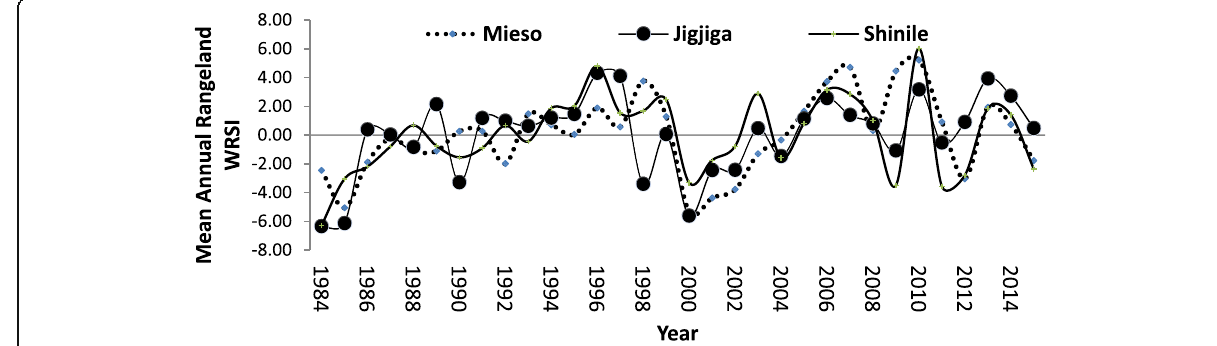
Fig. 3 Mean annual standardized rangeland WRSI values and trends for Mieso, Jigjiga, and Shinile districts over the period 1984 – 2015